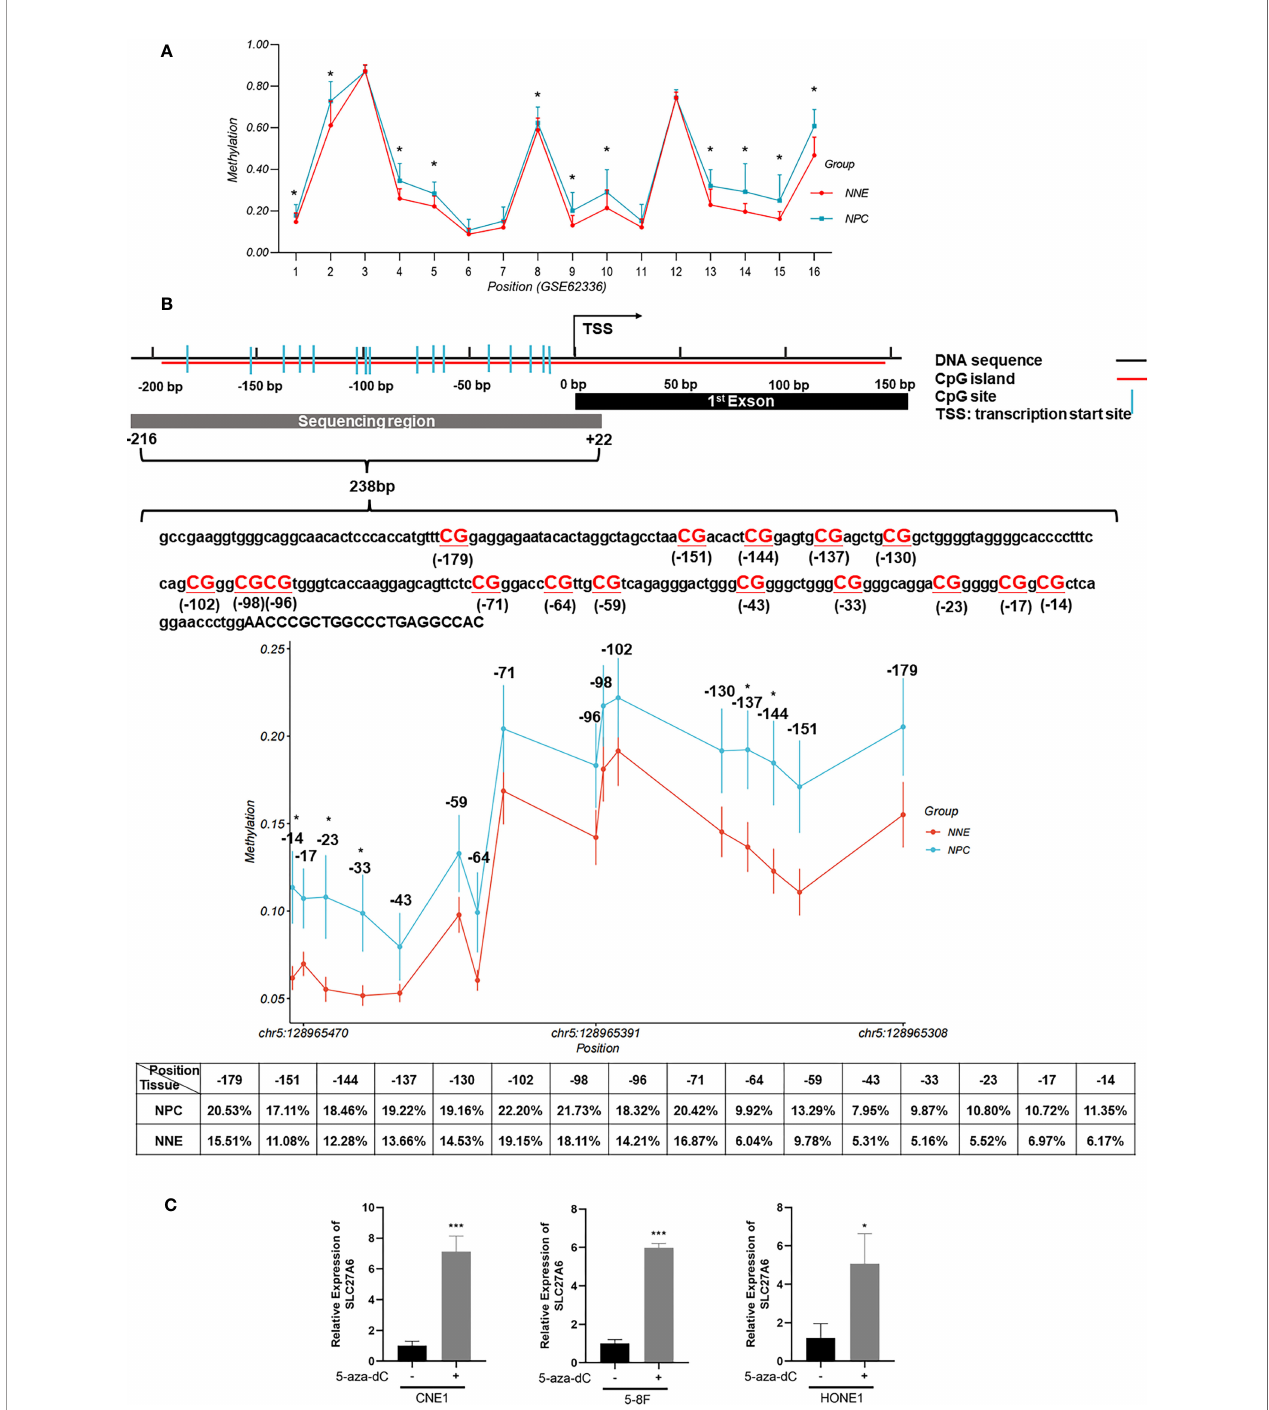
FIGURE 2 | DNA promoter hypermethylation of SLC27A6 in NPC and NNE tissue. (A) The promoter region of SLC27A6 included 16 CpG sites, and the average methylation ratio was analyzed via DNA methylation microarray data (GSE62336; 25NPC, 25NNE). (B) The extent of CpG methylation in 238 bp region within the SLC27A6 promoter was analyzed by the bisul fi te gene sequencing (NPC biopsies, n=20; NNE biopsies, n=9). (C) SLC27A6 mRNA expression in three NPC cell lines treated or untreated with demethylation reagent. * P < 0.05; *** P <